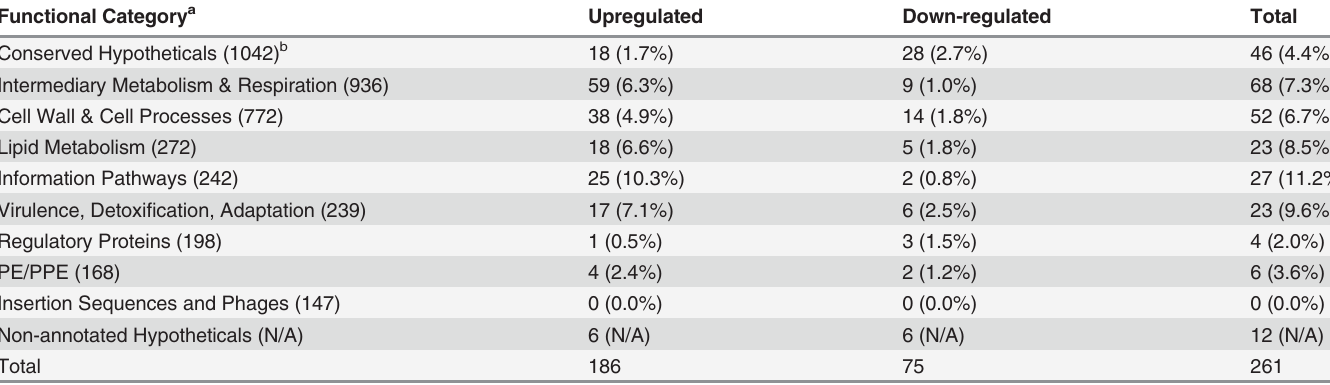
Table 1. Numbers of M . tb genes differentially expressed in A549 cells arranged by functional category. Functional Category